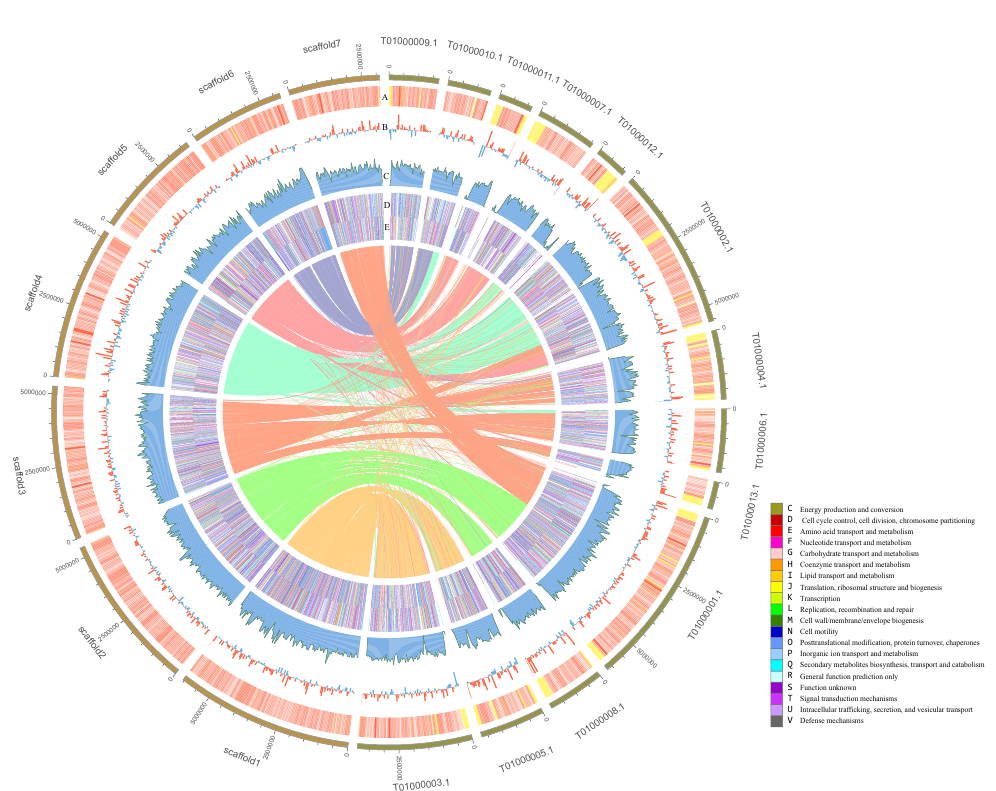
Figure 3. Genome comparison of Penicillium variabile HXQ-H-1 and Talaromyces islandicus WF-38-12. The lefts are the 7 sca ff olds of HXQ-H-1, and the rights are the 13 sca ff olds of WF-38-12. The collinear relationship between sca ff olds is connected by center thin lines. The scale of each small square of the outermost circle represents 5 kb. Circle A is GC heatmap. Circle B is the histogram of GC (red: G > C; blue: G < C). Circle C is gene density in chromosomes. Circles D and E are the COG positive / negative annotation heatmaps, and the legend is shown in the bottom